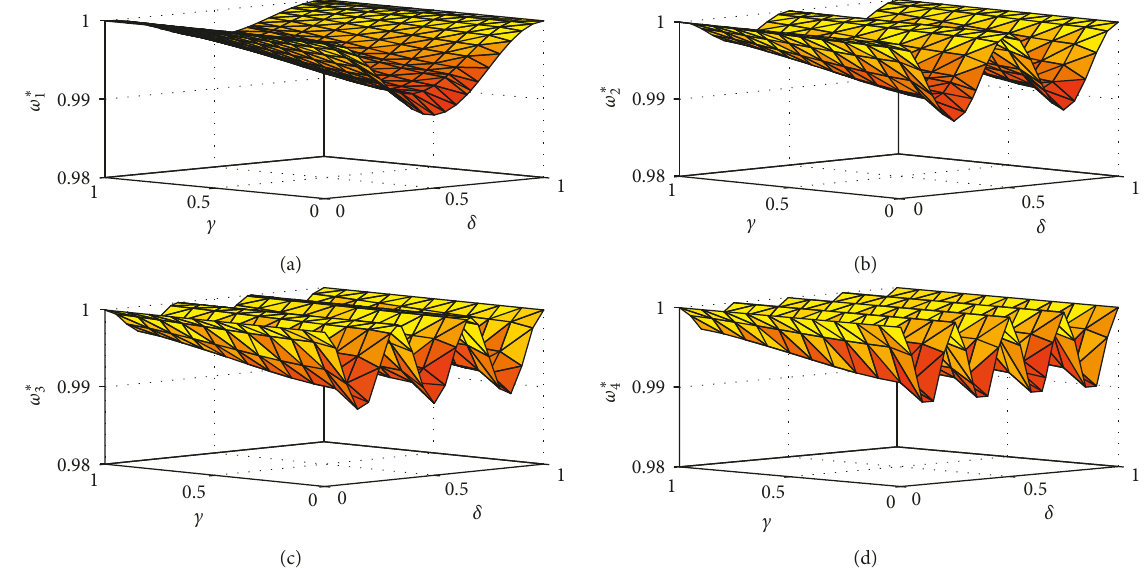
Figure 4: Variations of the first four normalized frequencies in terms of crack front shape ( c ) and position ( δ ) for α